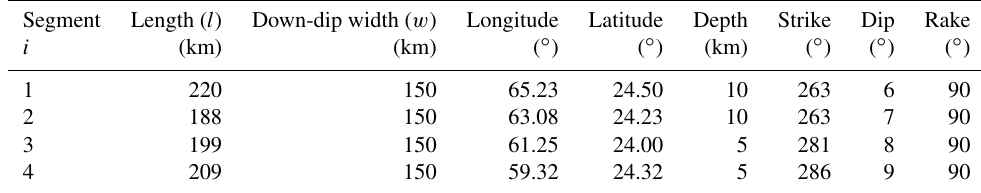
Table 2. Finite fault parameters of the four-segment tsunamigenic earthquake